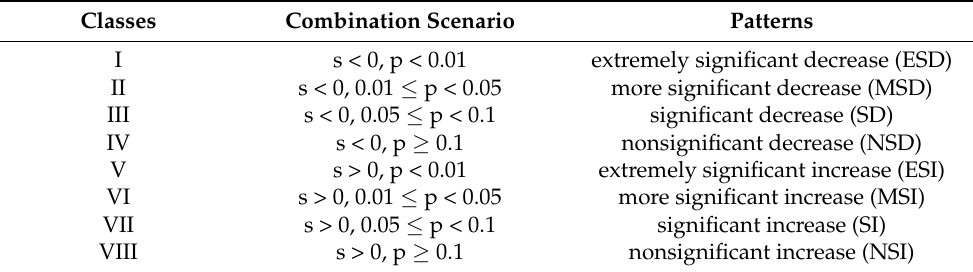
Table 2. Division of EVI and soil moisture content variation trend patterns.